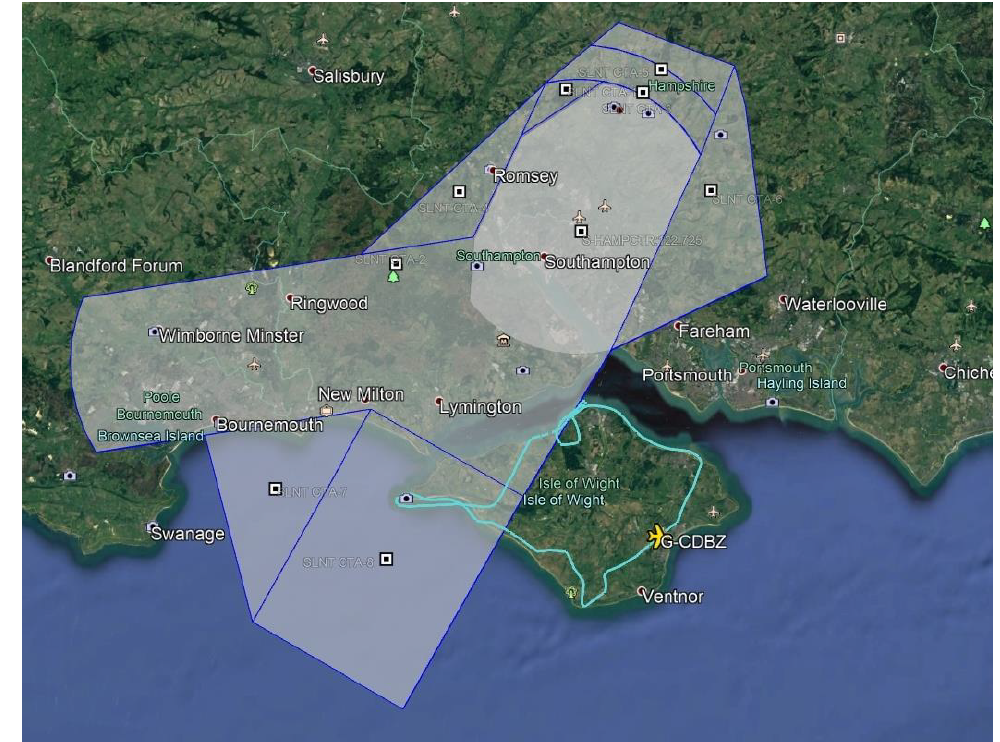
Figure 20. A screenshot from the second flight